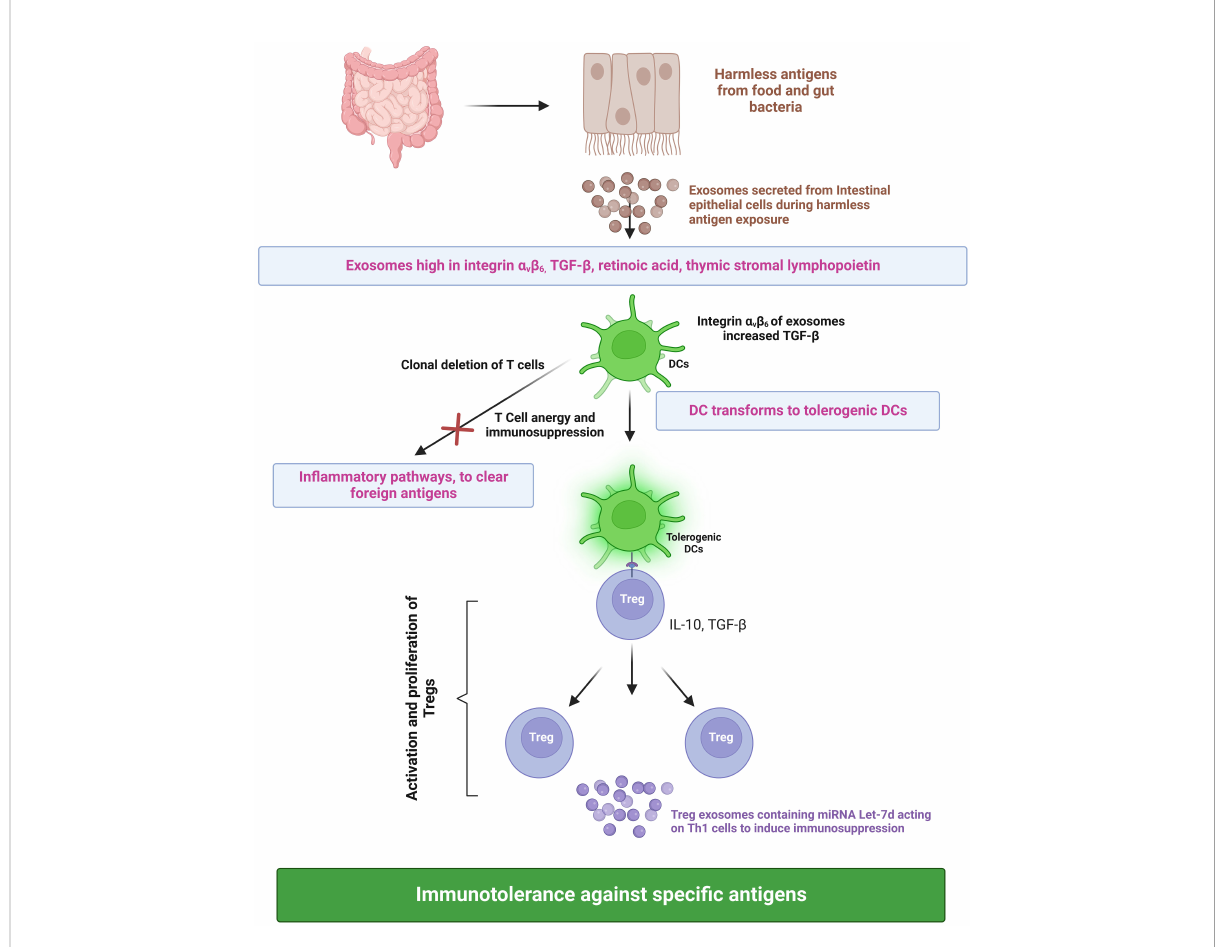
FIGURE 3 Roles of exosomes in inducing immune tolerance. TGF-b, Transforming growth factor beta; DC, Dendritic cell; IL-10, Interleukin 10; Treg, Regulatory T cells; Th1, T helper type 1; and miRNA, micro Ribonucleic Acid. Created with